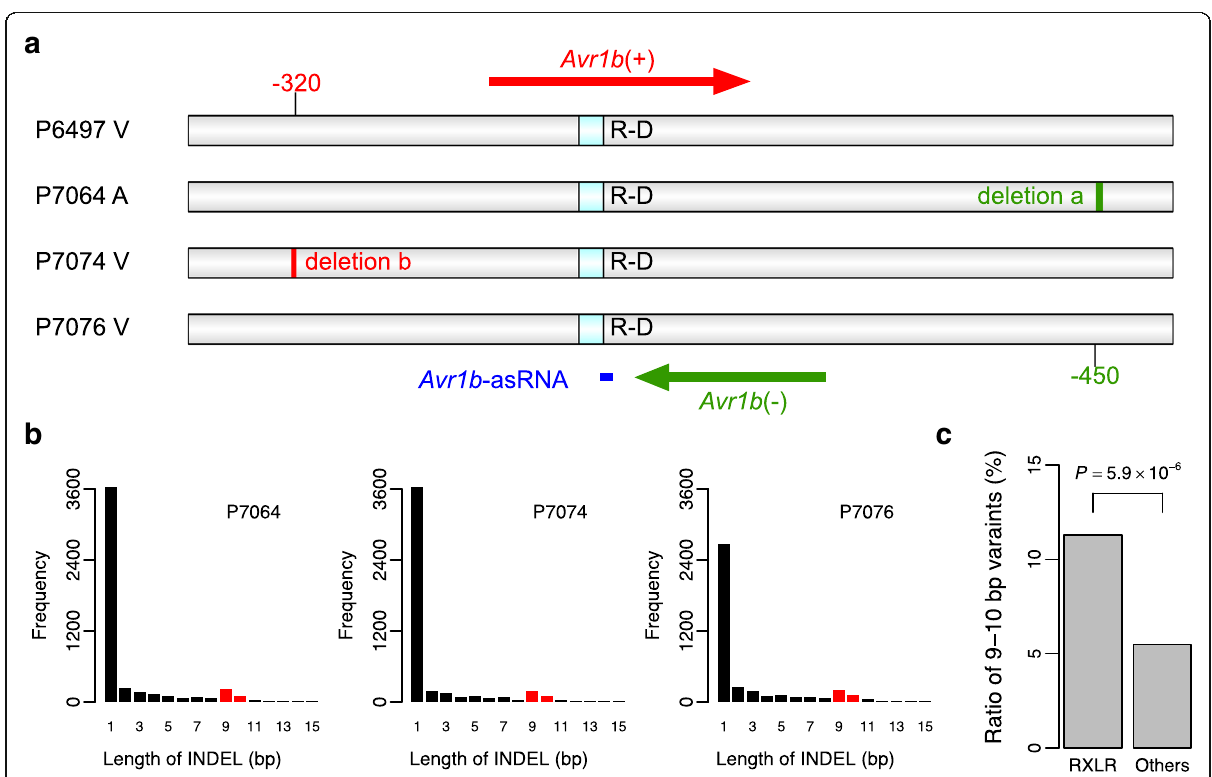
Fig. 6 INDEL variants identified in the regulatory regions of P. sojae genes. a Comparison of the sequence variation of regulatory regions for the Avr1b (+) and Avr1b ( − ). Variations in the Avr1b (+) and upstream sequences are marked in red, while that of Avr1b ( − ) and upstream sequences are marked in green. Avr1b -asRNA is marked in blue. R-D, the nucleotide sequence that encodes RXLR-DEER motif. b Frequency of the INDEL variants in the promoter region of P. sojae genes. The variants were called from the re-sequenced genomes of P. sojae strains P7064, P7074, and P7076, while the genome of strain P6497 was used as a reference. The 500bp upstream sequences were regarded as the promoters for each gene. c The 9 – 10bp INDEL variants are significantly enriched in the promoters of RXLR effector genes. One-sided Fisher ’ s exact test is used to access the